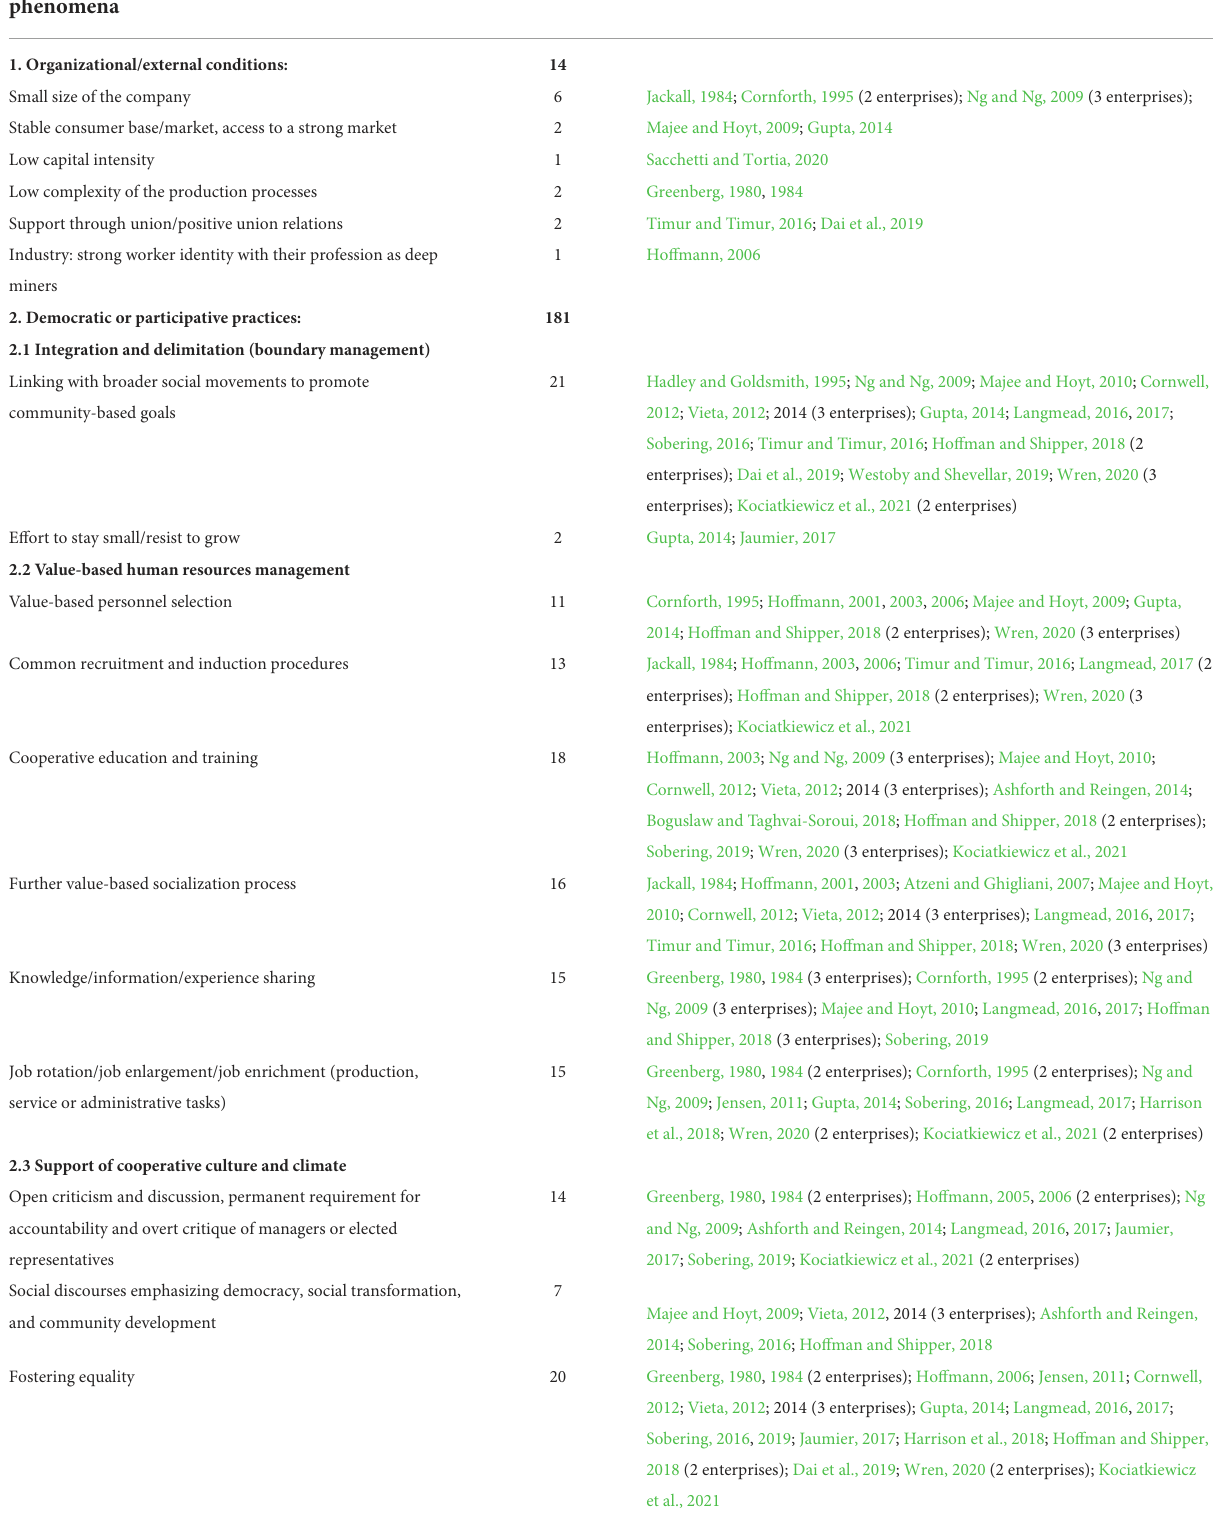
TABLE 4 Frequencies of conditions, practices, and psychological phenomena of all forms of retention mentioned ( n = 39 enterprises). Conditions, practices, and